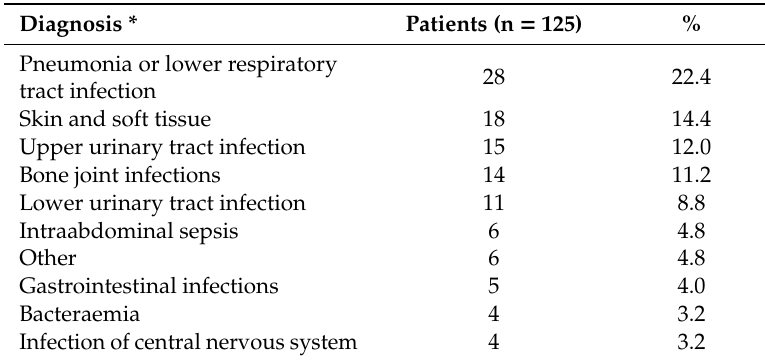
Table 1. Most common indications for therapeutic antibiotic prescription (CAI and HAI) among adults and children. Diagnosis * Patients (n = 125) % Pneumonia or lower